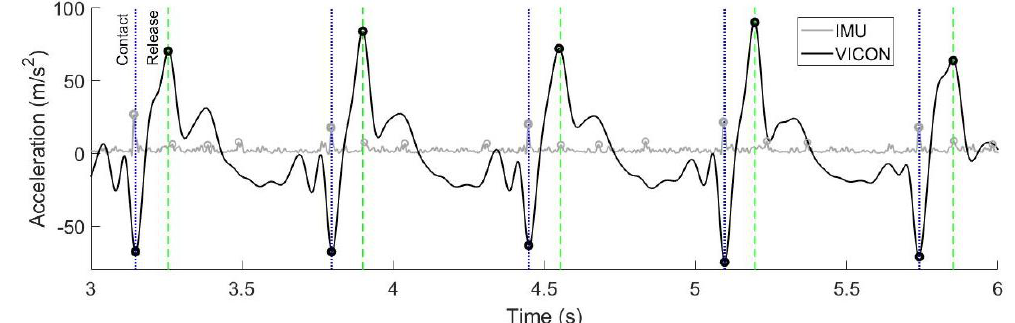
Figure 2. Representative example of acceleration trace demonstrating the clear detection of contact points with an IMU, however issues with the identification of